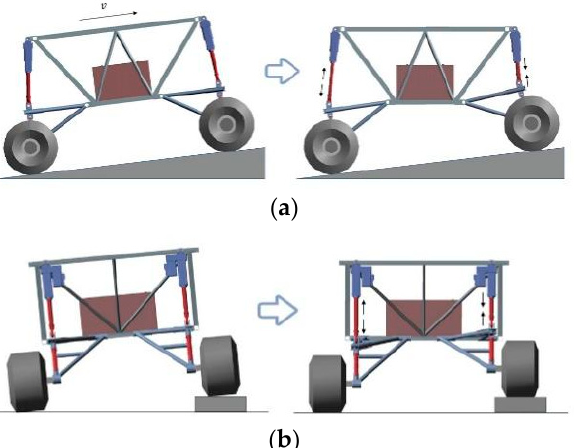
Figure 7. Ideal posture of ATV attitude control: ( a ) Pitching control process; ( b ) Rolling control process.